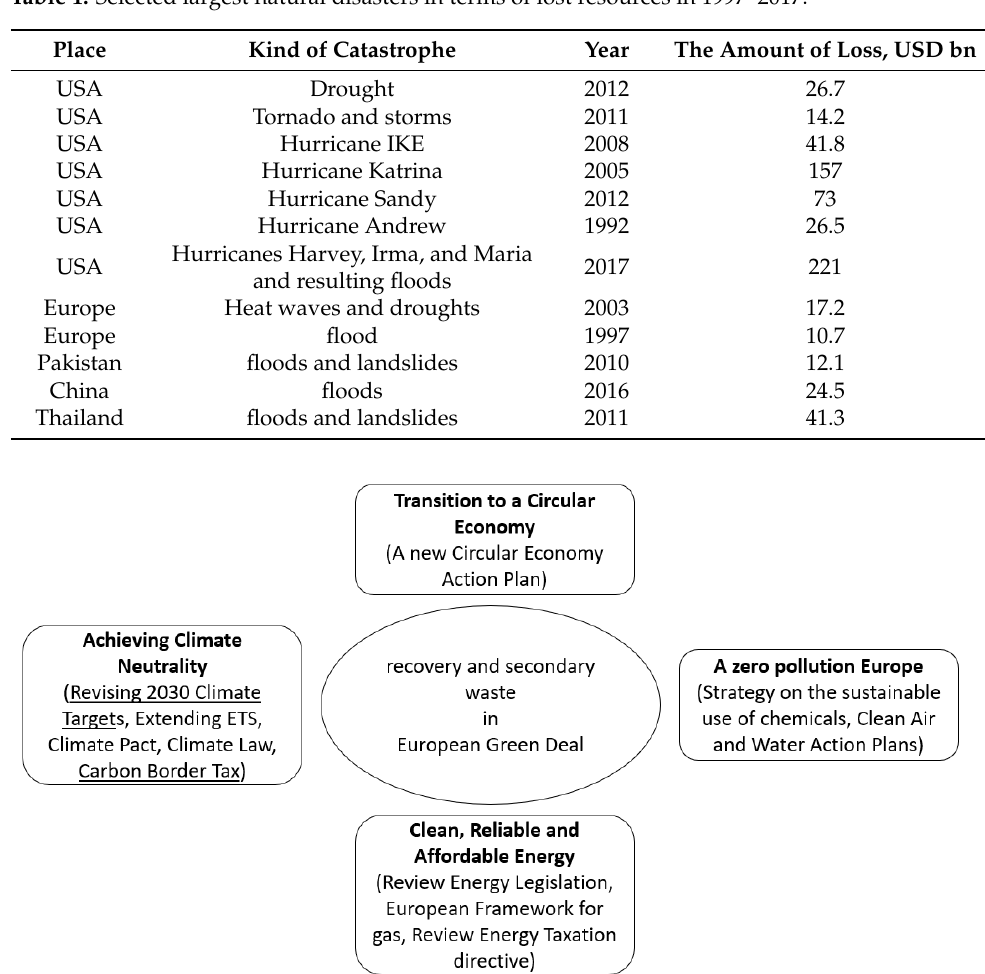
Table 1. Selected largest natural disasters in terms of lost resources in 1997–2017.